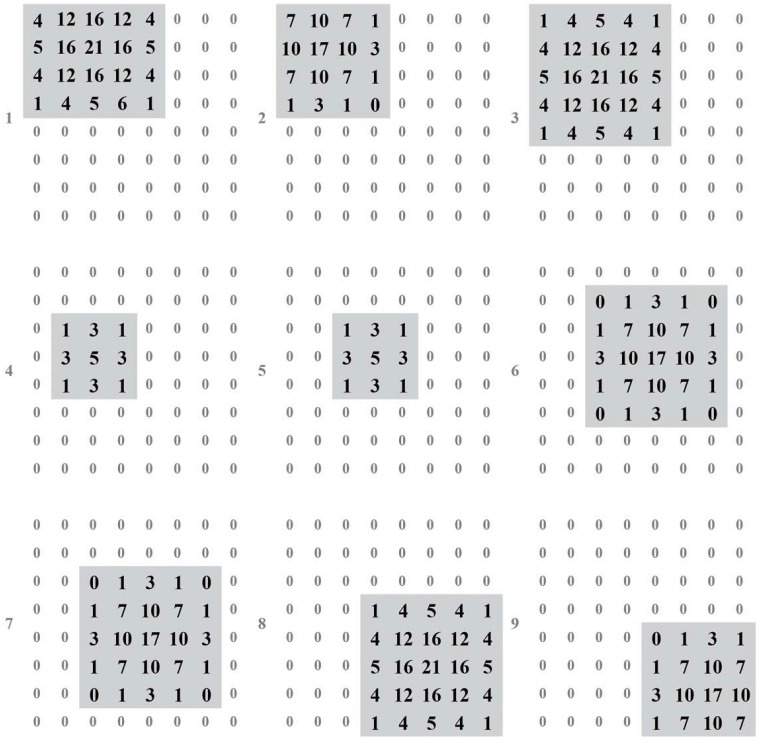
Output of layer 2.